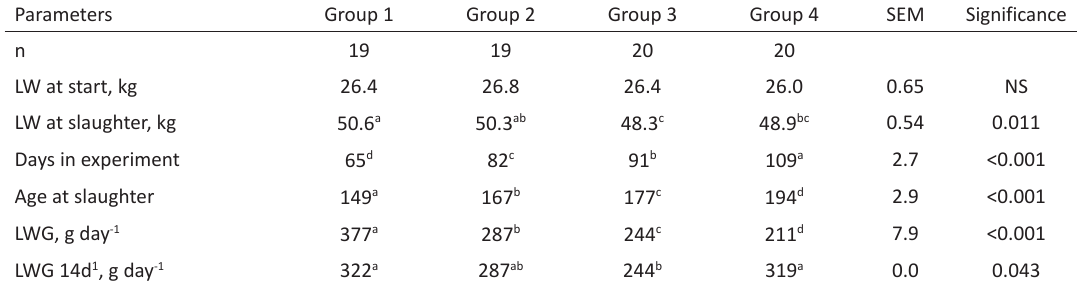
Table 3. Live weight (LW), age and live weight gain (LWG) of lambs reared using four different production systems Parameters Group 1